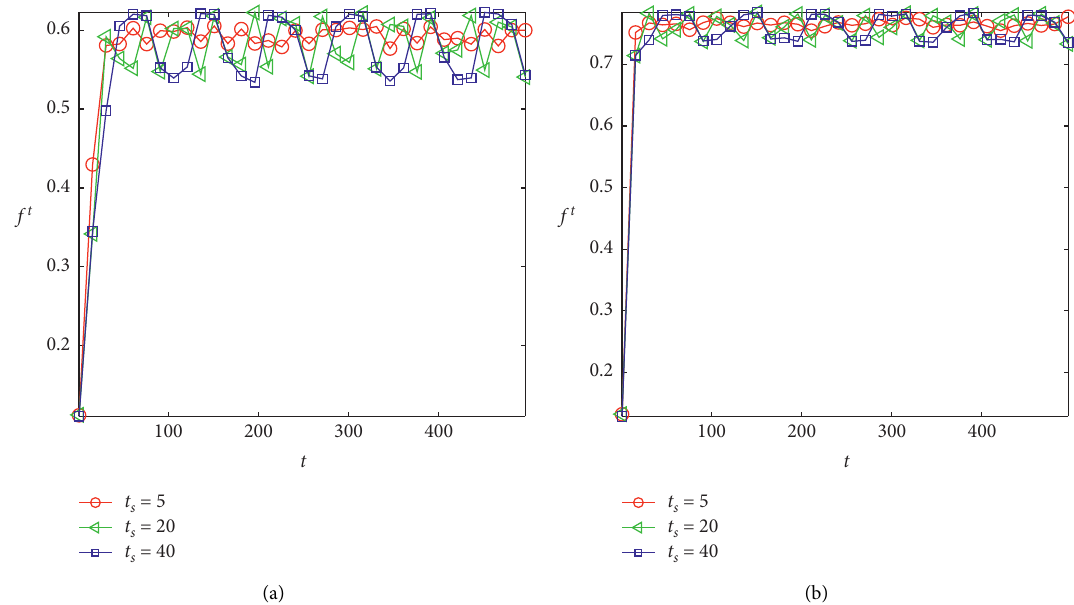
Figure 5: The evolution of infected density f t over time under different half period t β � 0 . 1. (a) The infection rate λ